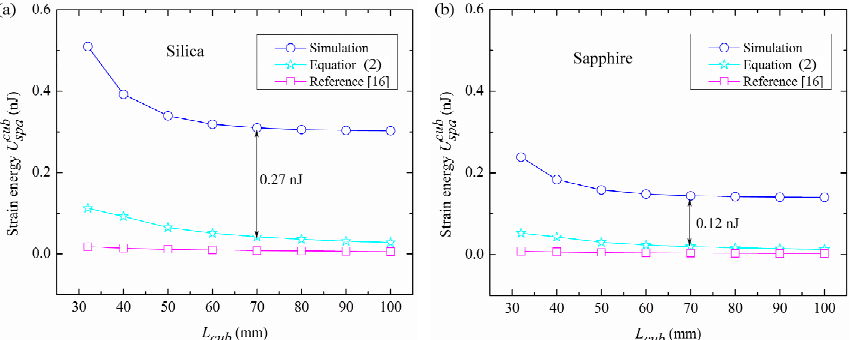
Figure 4. Strain energy as a function of edge L cub of the cubic spacer. The solid blue line with circles presents the simulation results. Magenta solid line with squares presents the analytic estimate according to Equation (2) in Ref. [16]. Cyan solid line with stars presents the analytic estimate ac- cording to Equation (2). ( a ) Silica cubic spacer with silica substrates. ( b ) Sapphire cubic spacer with sapphire substrates.